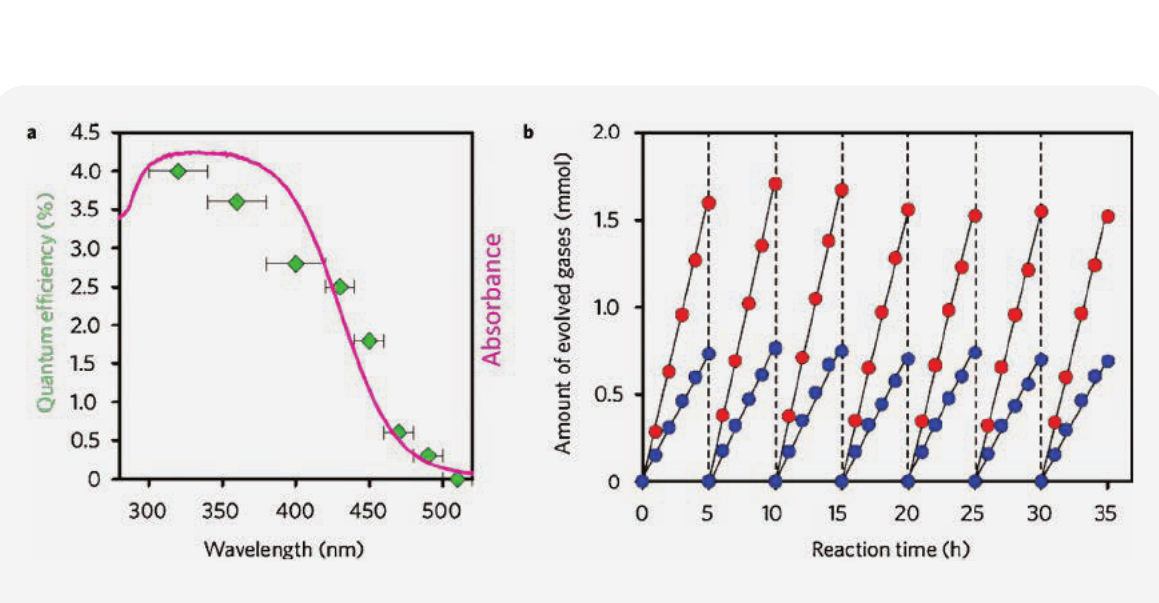
Figure 4. (a) Comparison of quantum effi ciencies with the absorption spectrum of ZnO:GaN. (b) Rate of evolution of H 2 and O 2 with ZnO:GaN. Repro- duced with permission from Ref. 10. Copyright 2005, American Chemical